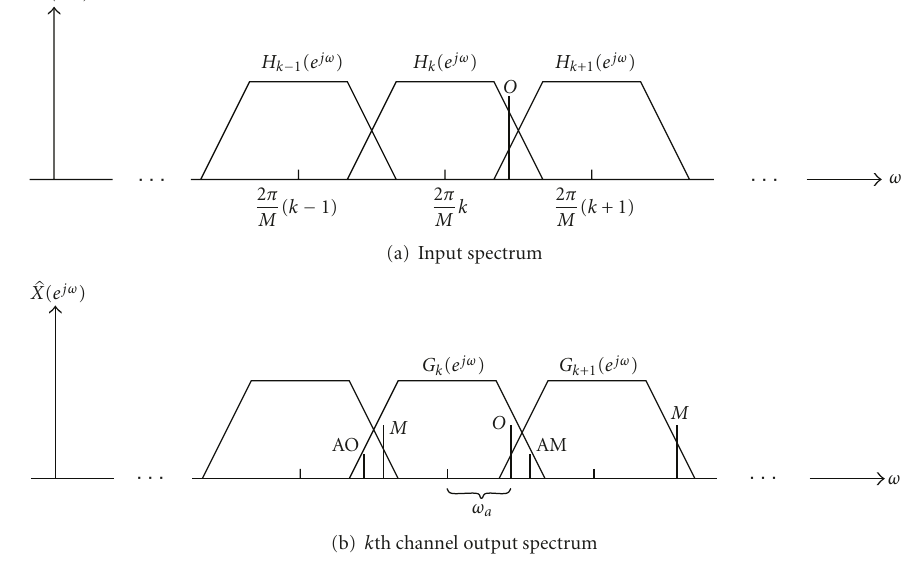
Figure 2: Spectrum change after real and imaginary